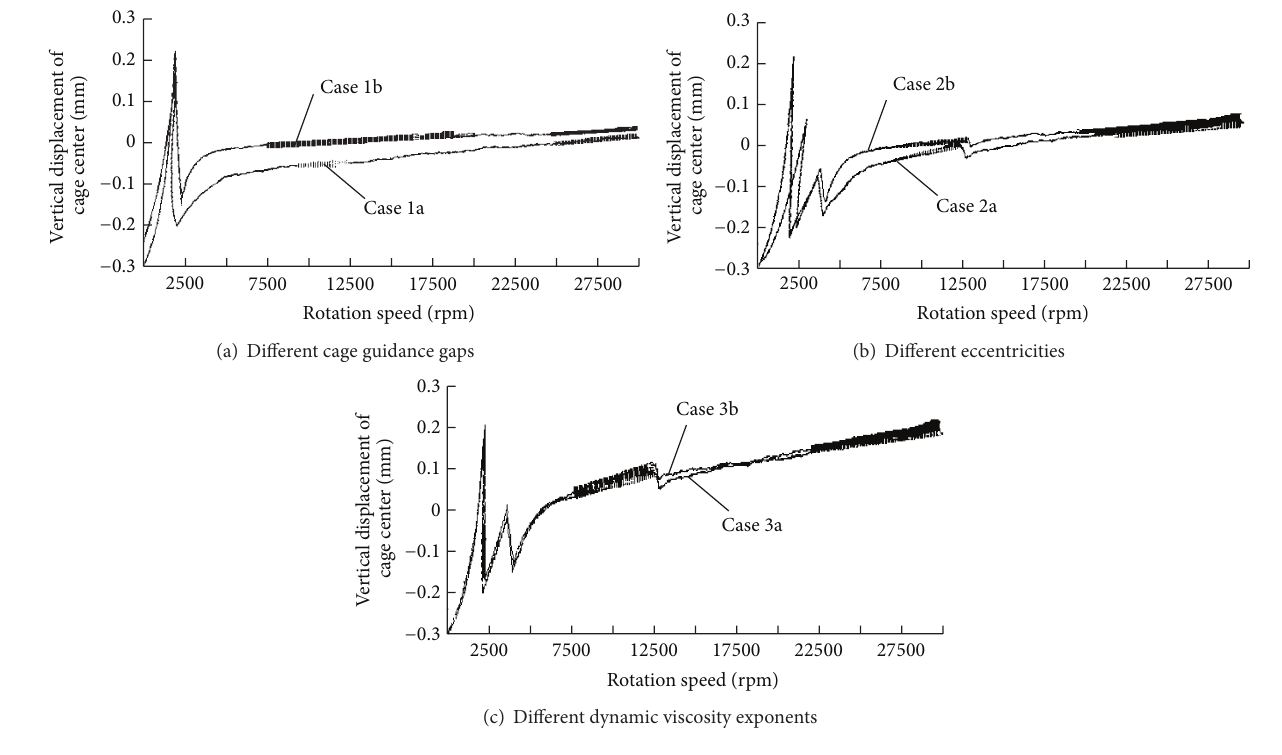
Figure 7: Bifurcation diagram points, 𝑋 𝐶 versus spin speed. Table 1: Specifications of the bearing structure and size.